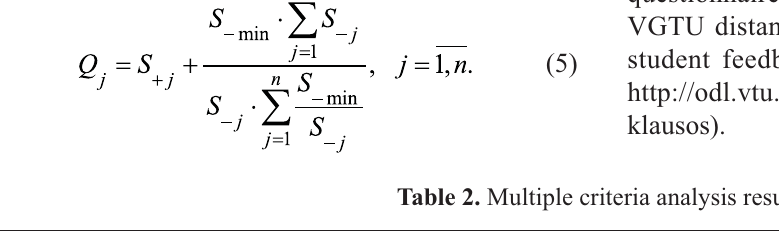
Table 2. Multiple criteria analysis